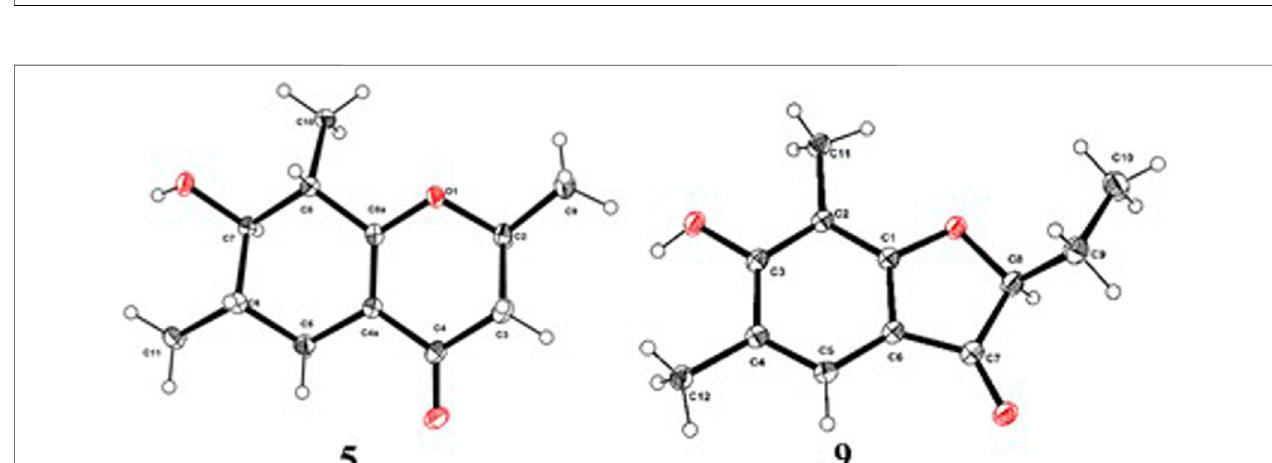
FIGURE 8 | ORTEP drawings of the X-ray structures for compounds 5 and